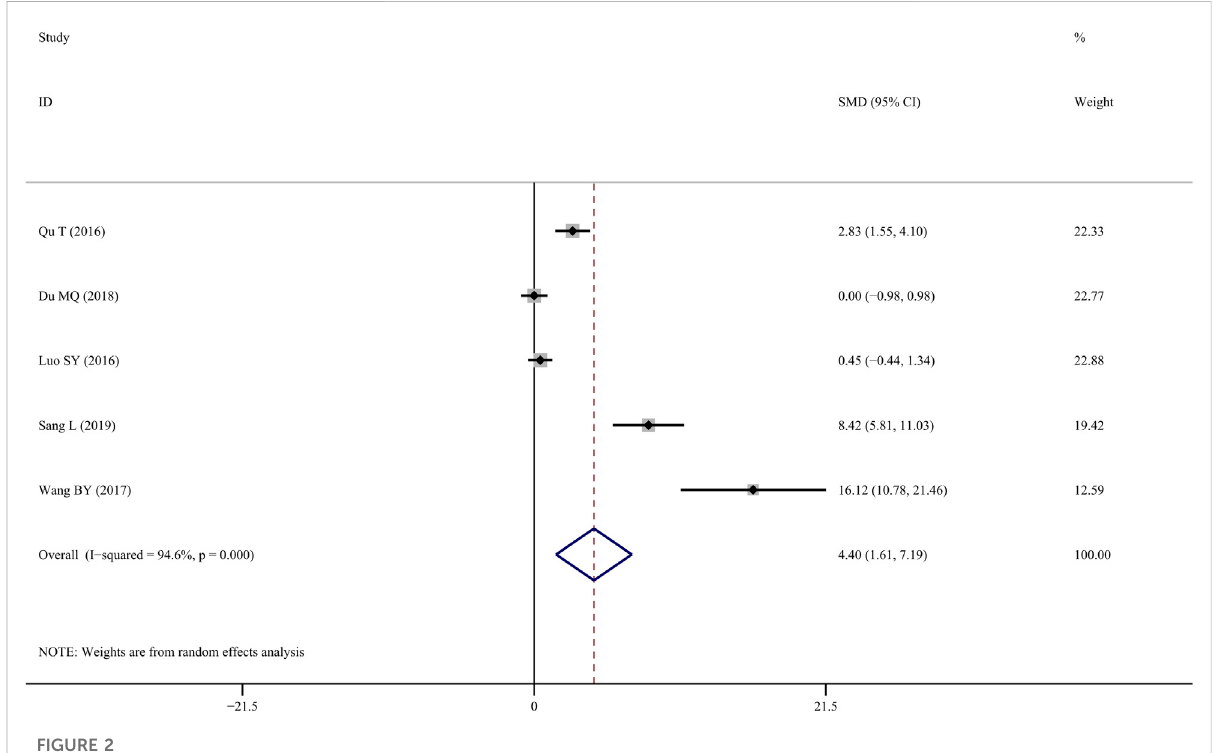
FIGURE 2 Effect of tanshinol on BMD-femur change in osteoporosis